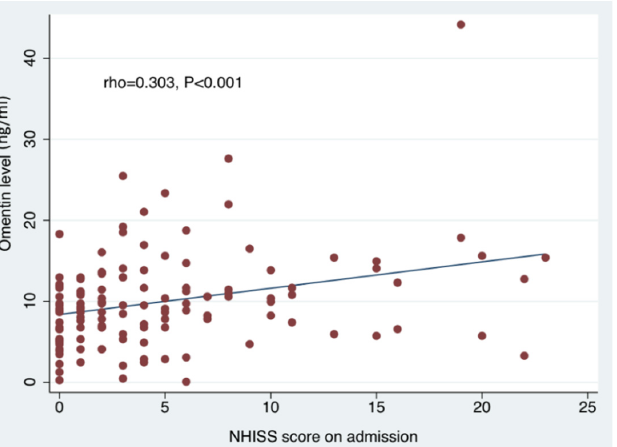
Figure 2. Spearman’s rank–order correlation depicts a significant correlation between NIHSS on admission and circulating omentin levels (ng/ml). NIHSS: National Institutes of Health Stroke Scale.